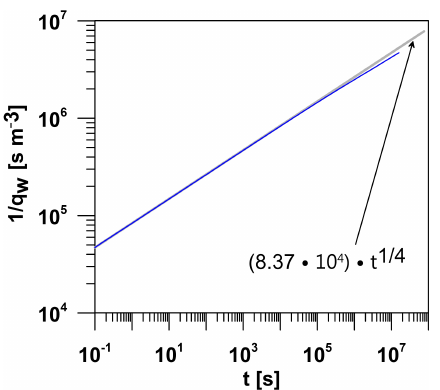
Figure 10. 1 /q w (sm − 3 ) vs. t (s) on a log–log scale. The synthetic curve is represented by the blue line and the bilinear fit curve is indicated with the grey